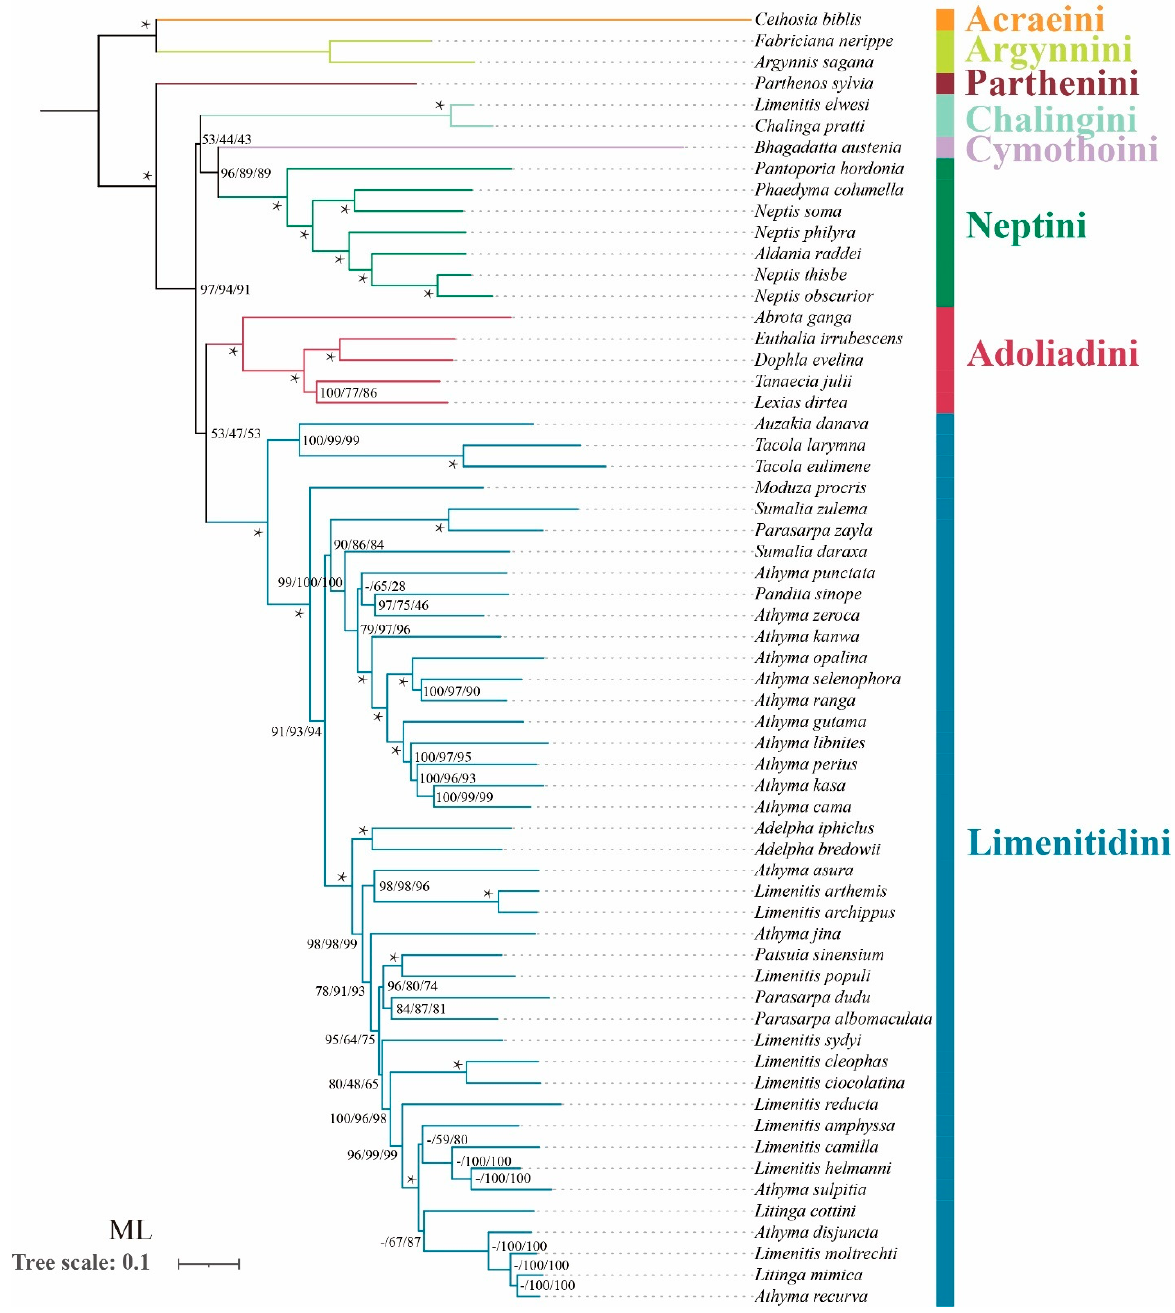
Figure 4. Phylogenetic tree produced by maximum likelihood analyses based on the datasets of PCG123, PCG123R and PCG123RT. Supports at nodes (from left to right) are bootstrap support values (BS) for PCG123, PCG123R and PCG123RT. “-” indicates the clades are different. Star symbol indicates that three datasets produced a maximum support value.